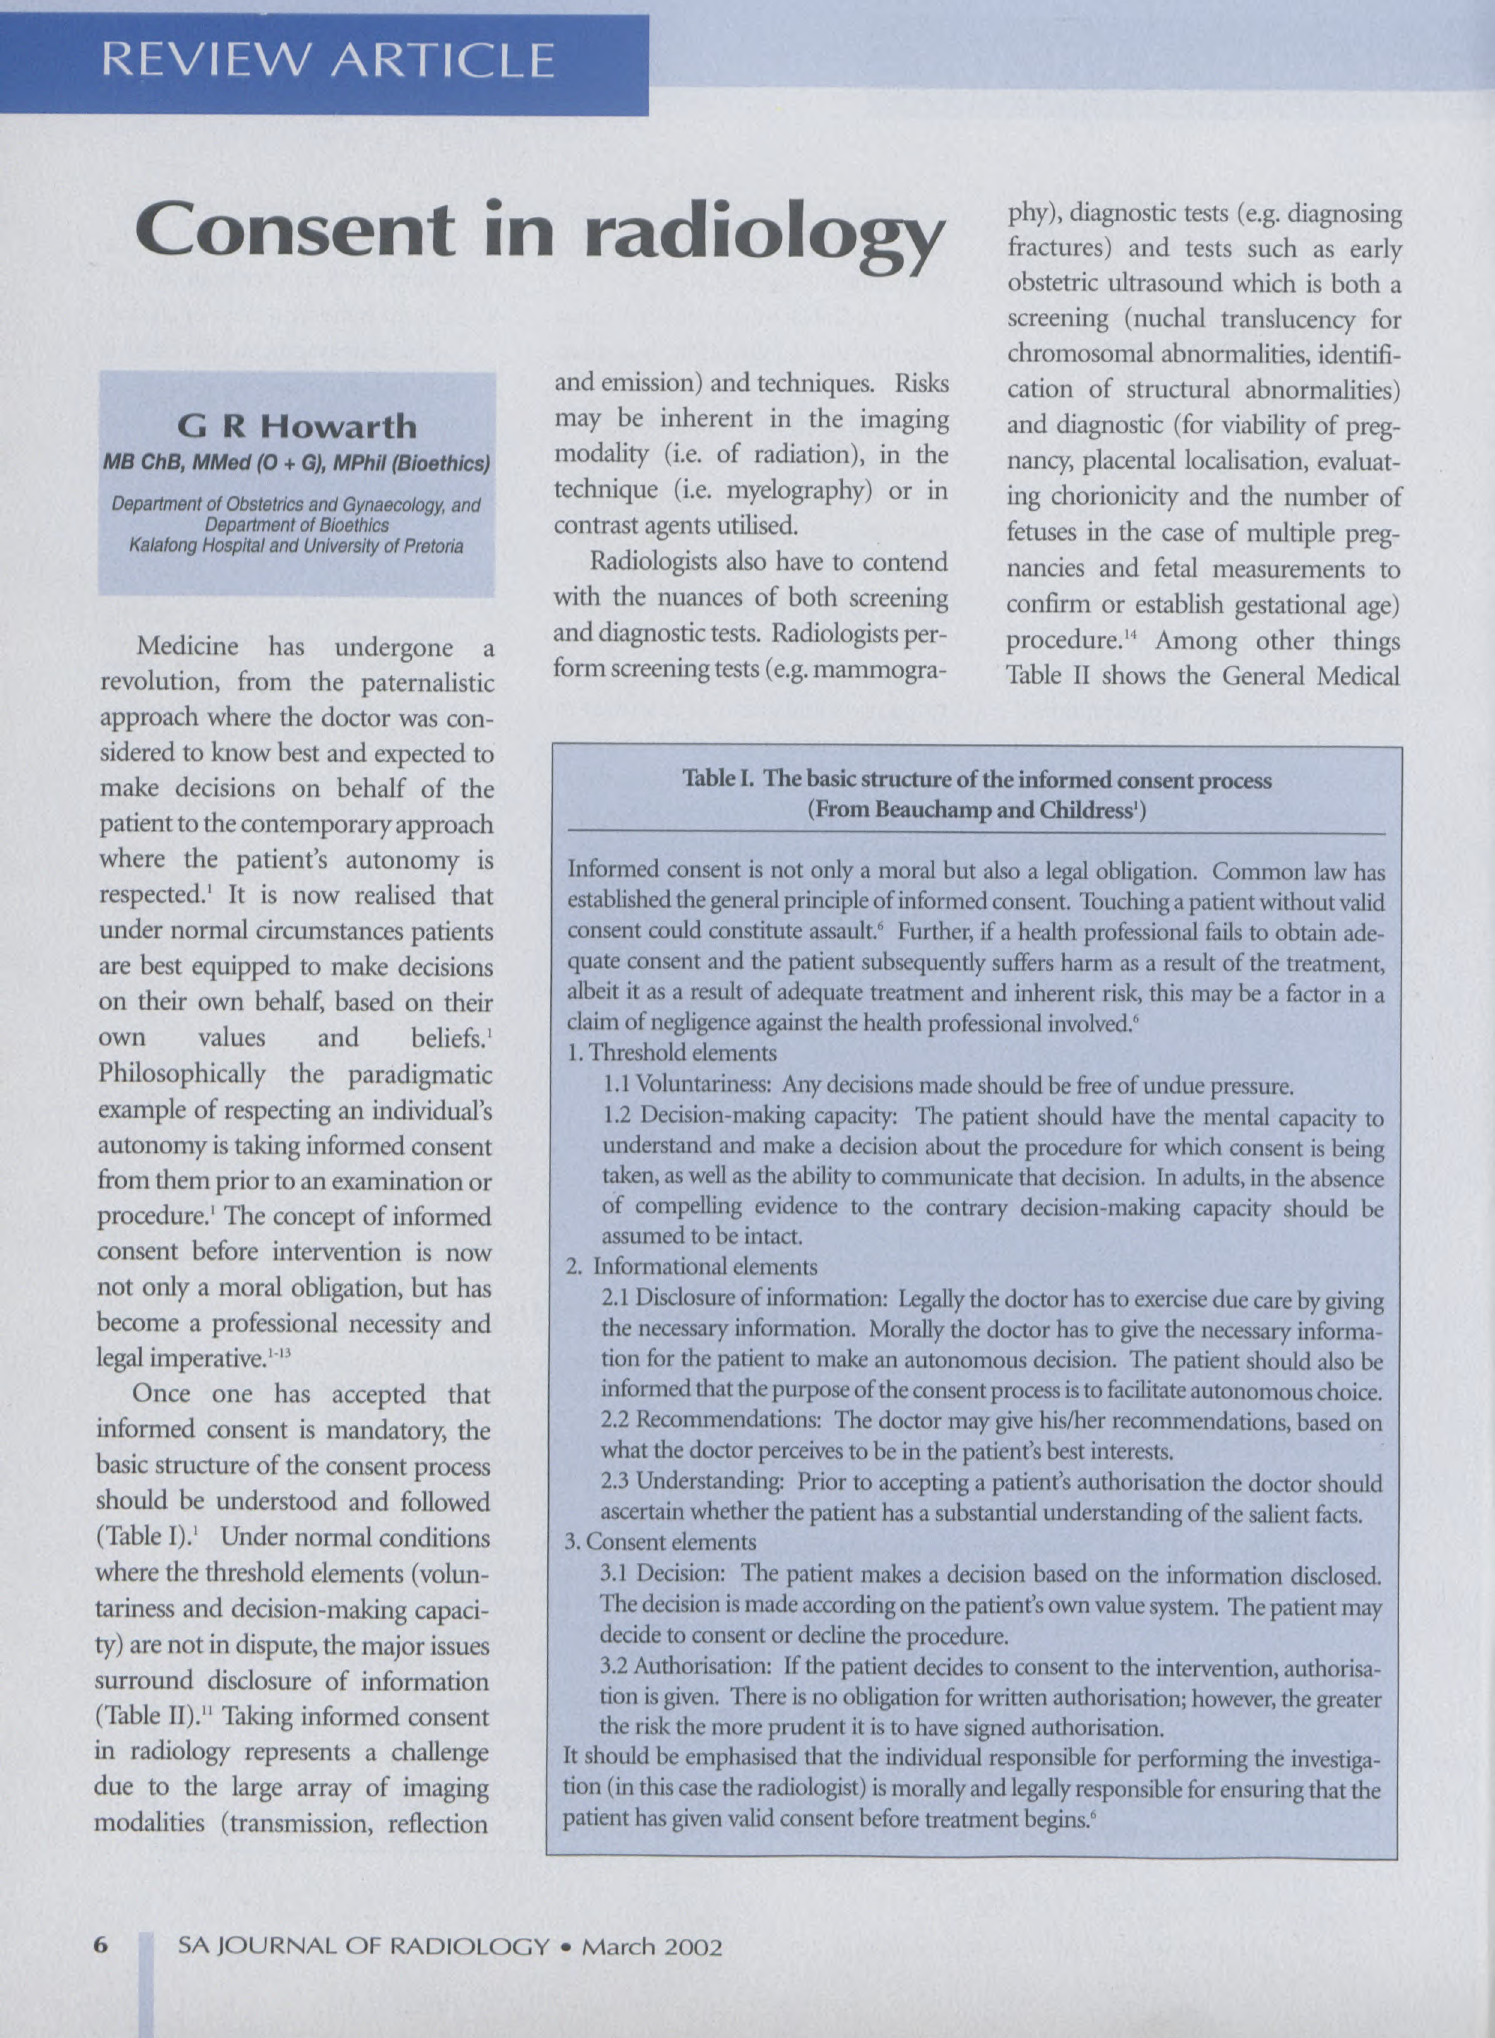
Table I. The basic structure of the informed consent process (From Beauchamp and